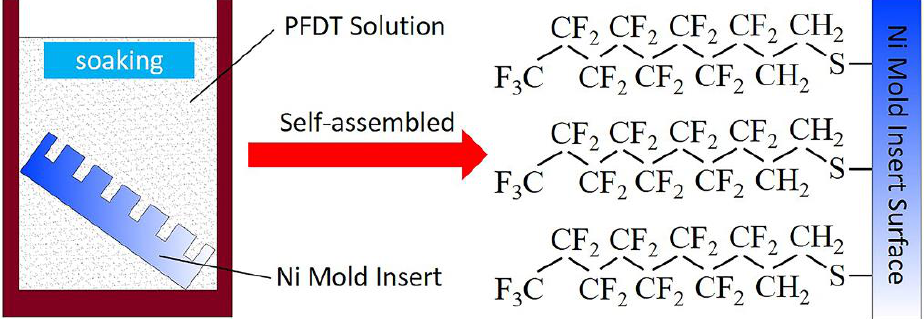
Figure 4. Self-assembled PFDT on the surface of Ni mold insert.